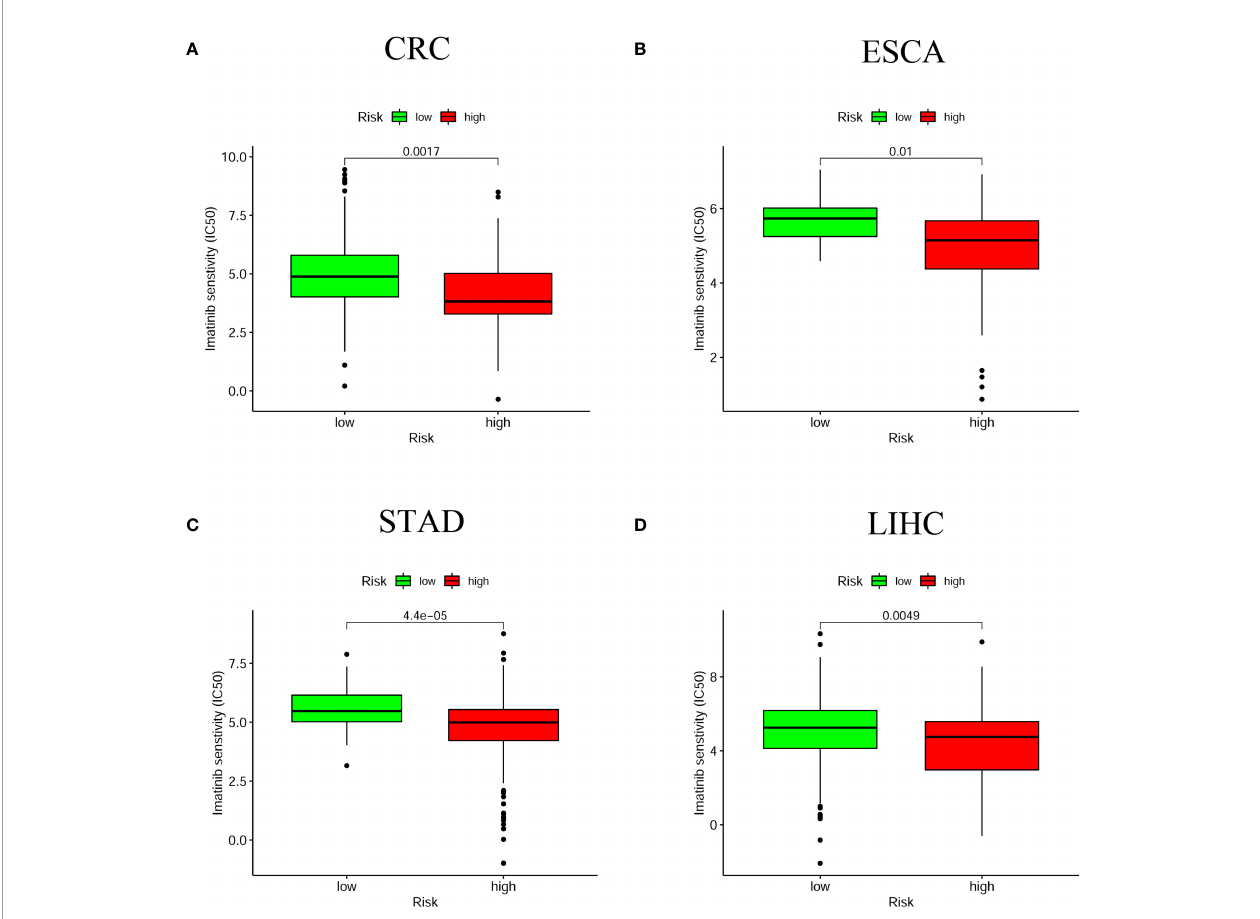
FIGURE 9 | The relationship between risk scores and anti-tumor drugs. The high-risk group in the four digestive system tumors was associated with a lower IC50 for Imatinib (A) CRC; (B) ESCA; (C) STAD; (D) LIHC. P < 0.05 was signi fi